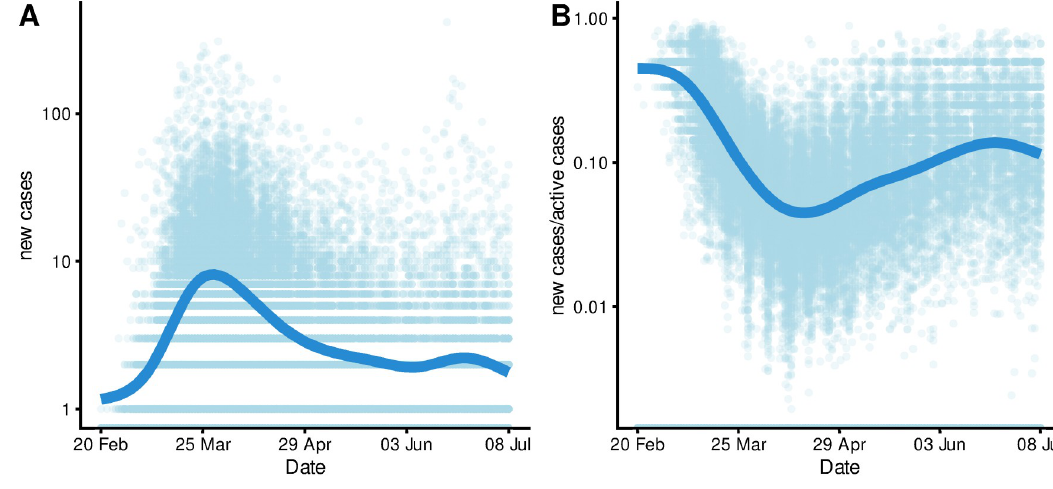
Fig 2. Temporal and district level variation of outcome (log-scale).